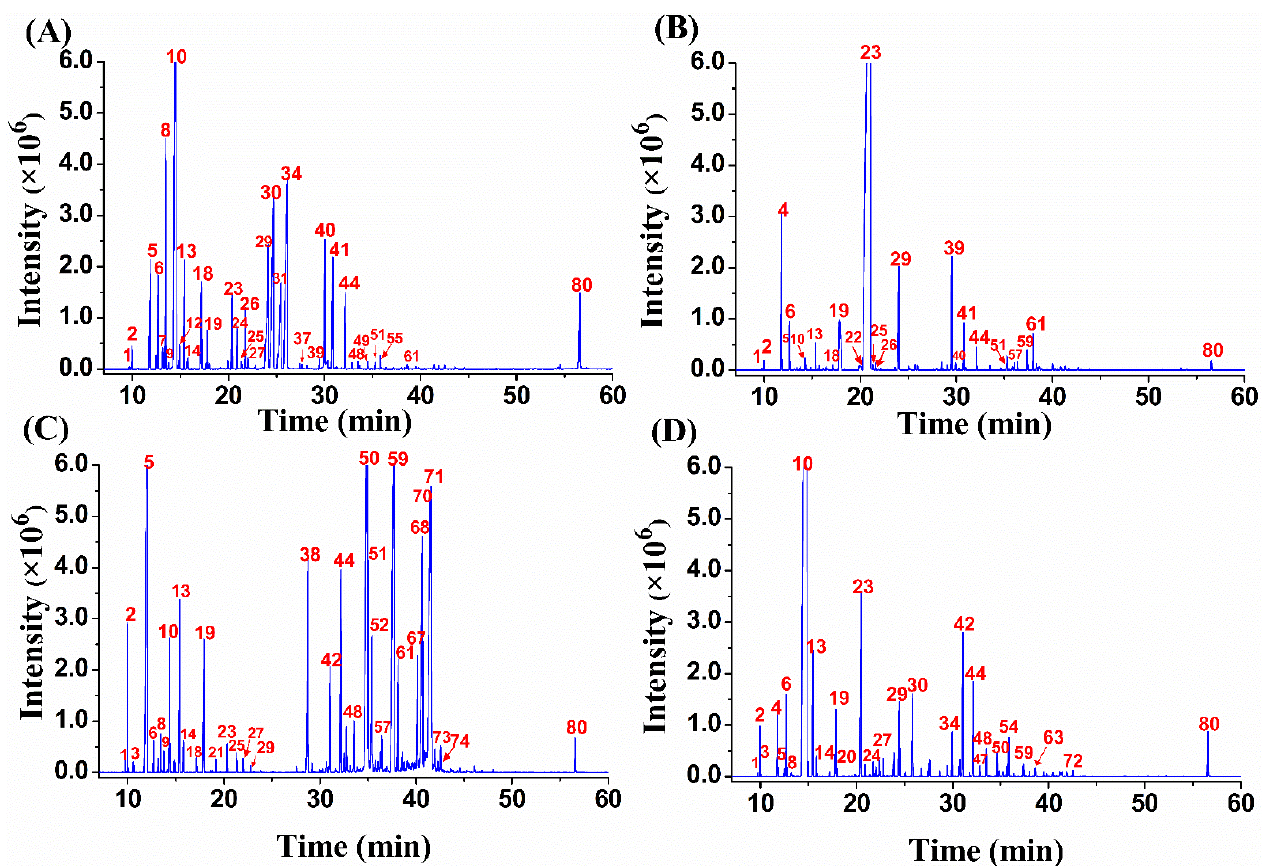
Figure 1. Total ion chromatograms (TICs) of four Citrus spp. leaf essential oils. ( A ) C. limon ; ( B ) C. hystrix ; ( C ) C. microcarpa ; and ( D ) C. pyriformis . The numbering of the phytoconstituents is provided in Table S1 (Supplementary Information).